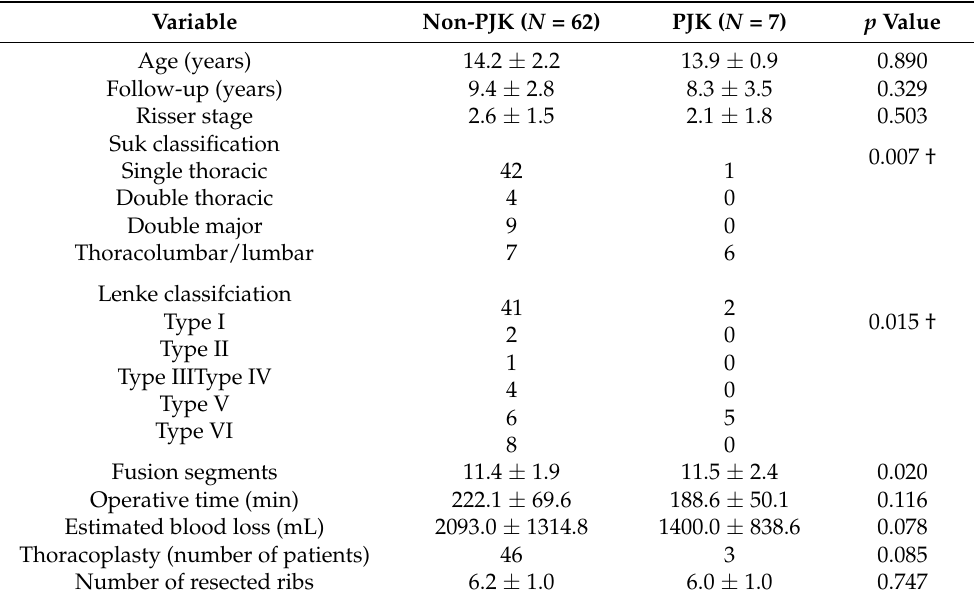
Table 1. Demographic and operative data of comparison between the non-PJK and PJK group.